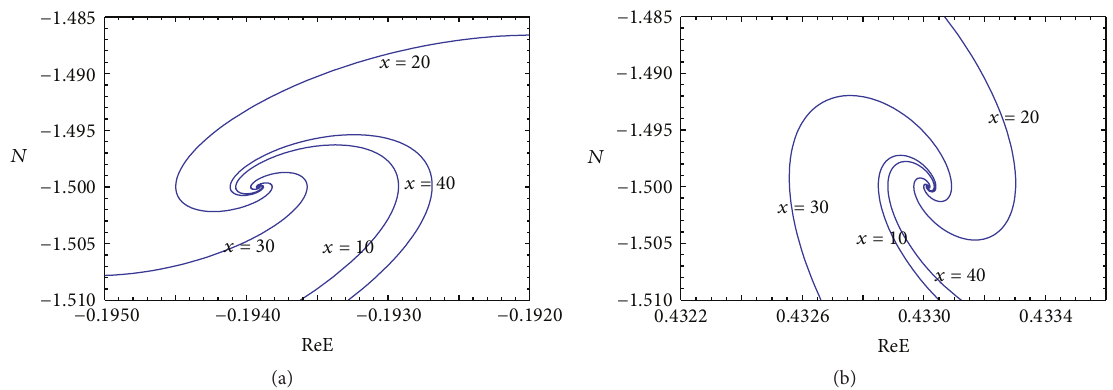
Figure 2: Spiral heteroclinic orbits for Schr¨odinger-Boussinesq equation as 𝑡 → −∞ (a) and 𝑡 → +∞ (b).